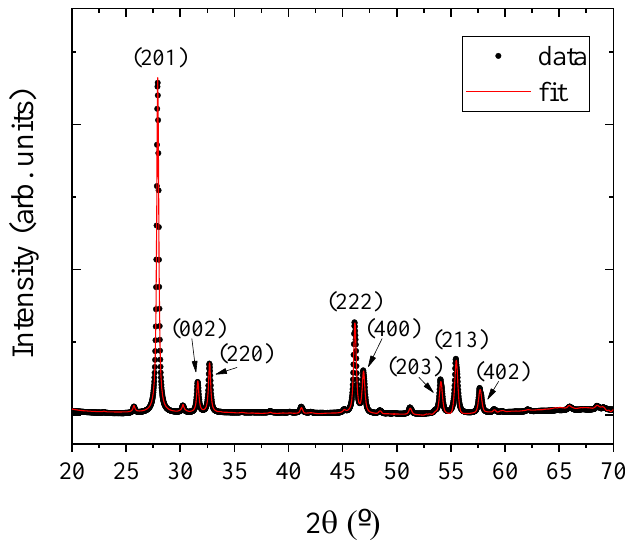
ff raction pattern with respective Rietveld fit for a Bi Figure 4. XRD diffraction pattern with respective Rietveld fit for a Bi 2 O 3 film. Figure 4. XRD di